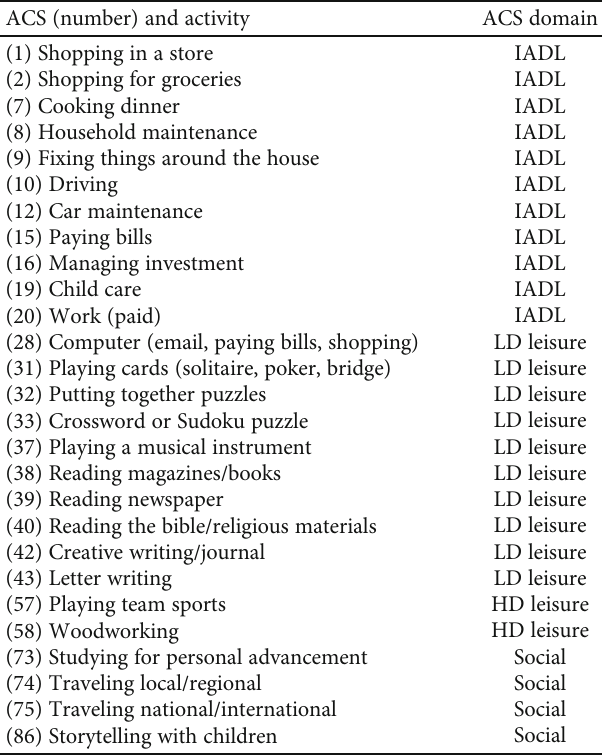
Table 2: High-cognitive skill activities ( n = 27 ).